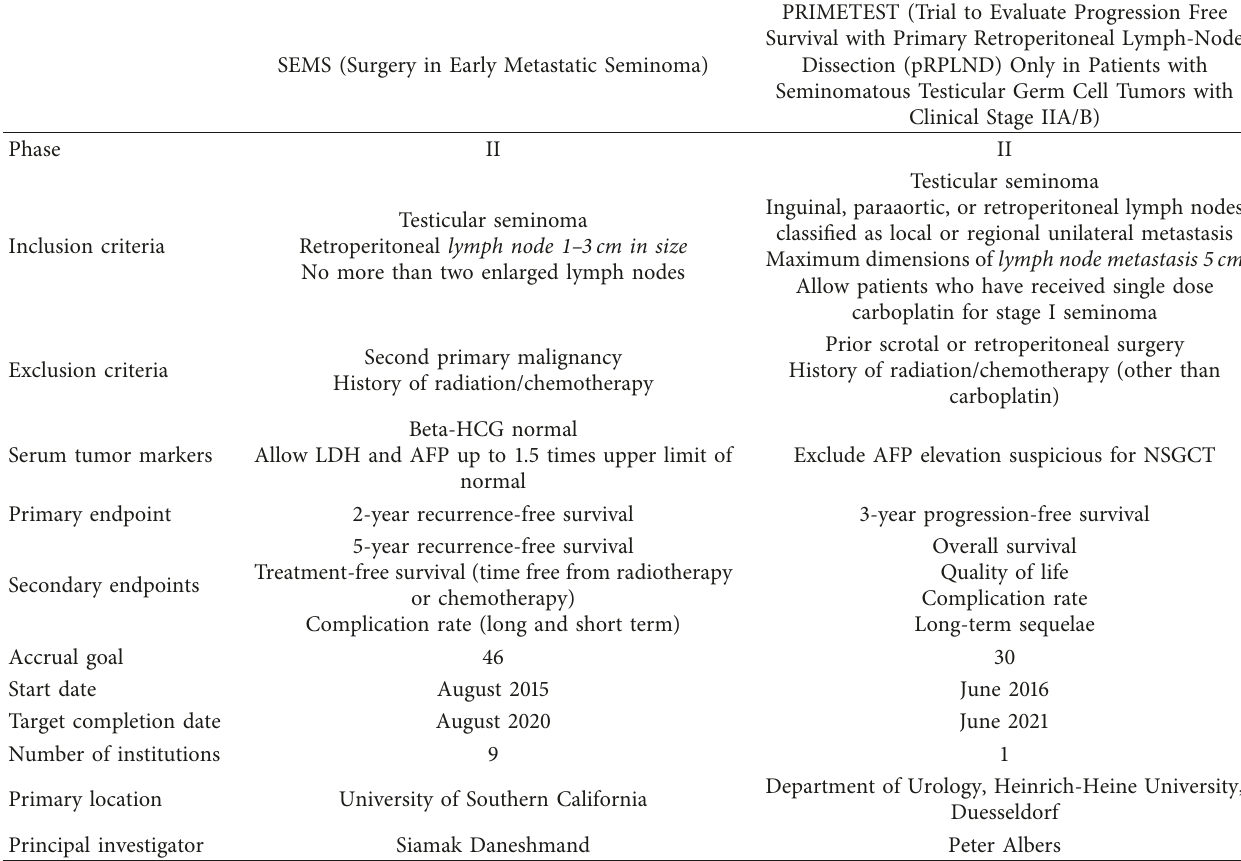
Table 3: Prospective clinical trials of RPLND in seminoma.